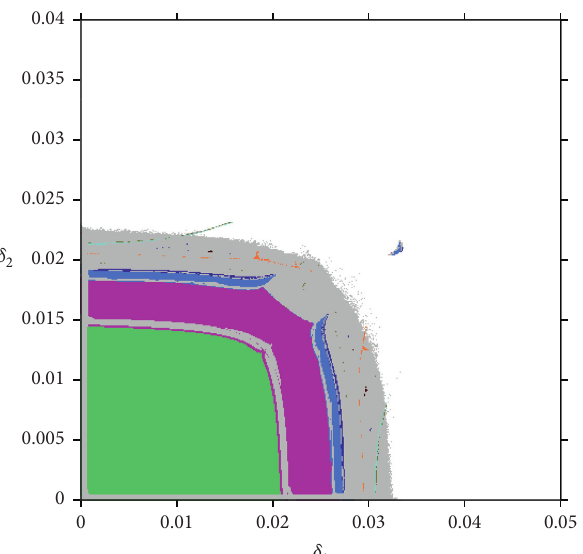
Figure 4: The 2D bifurcation diagram of dynamic system (15) in the ( δ